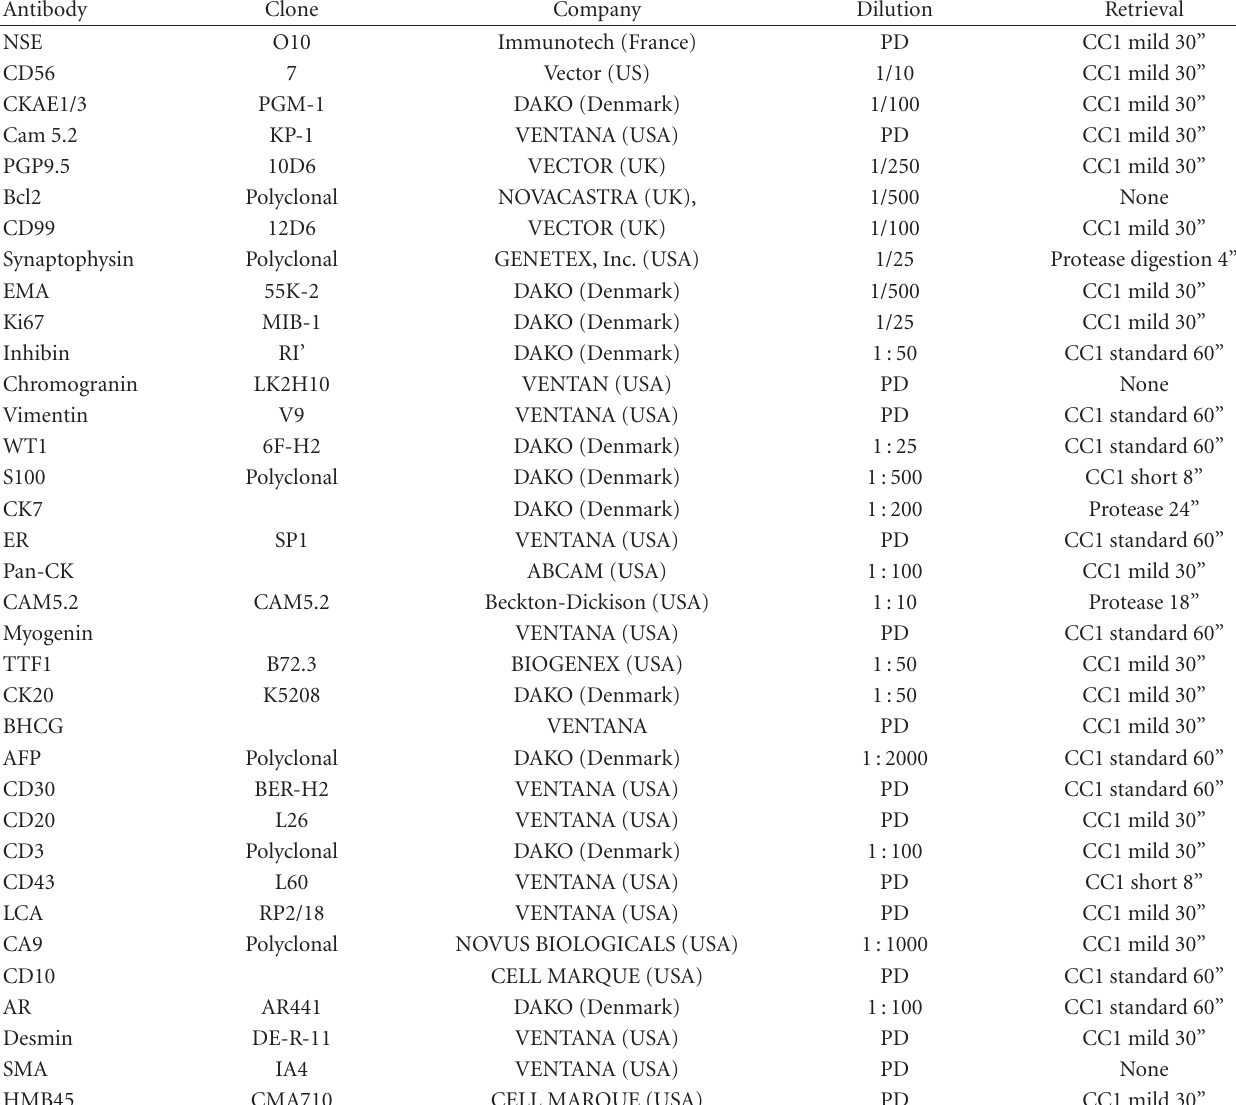
Table 1: Specifications of the antibodies used in the